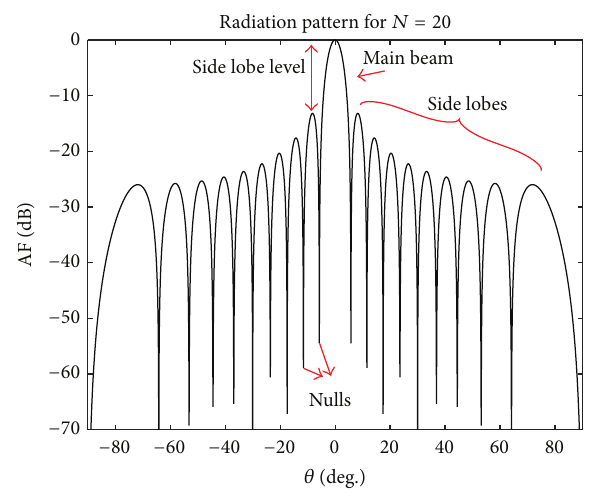
Figure 2: Template radiation